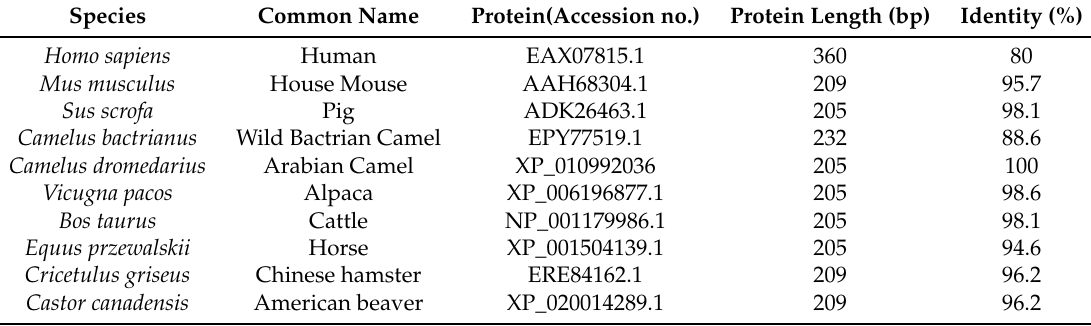
Table 5. Homology of cLin-28 amino acids with those from other species.